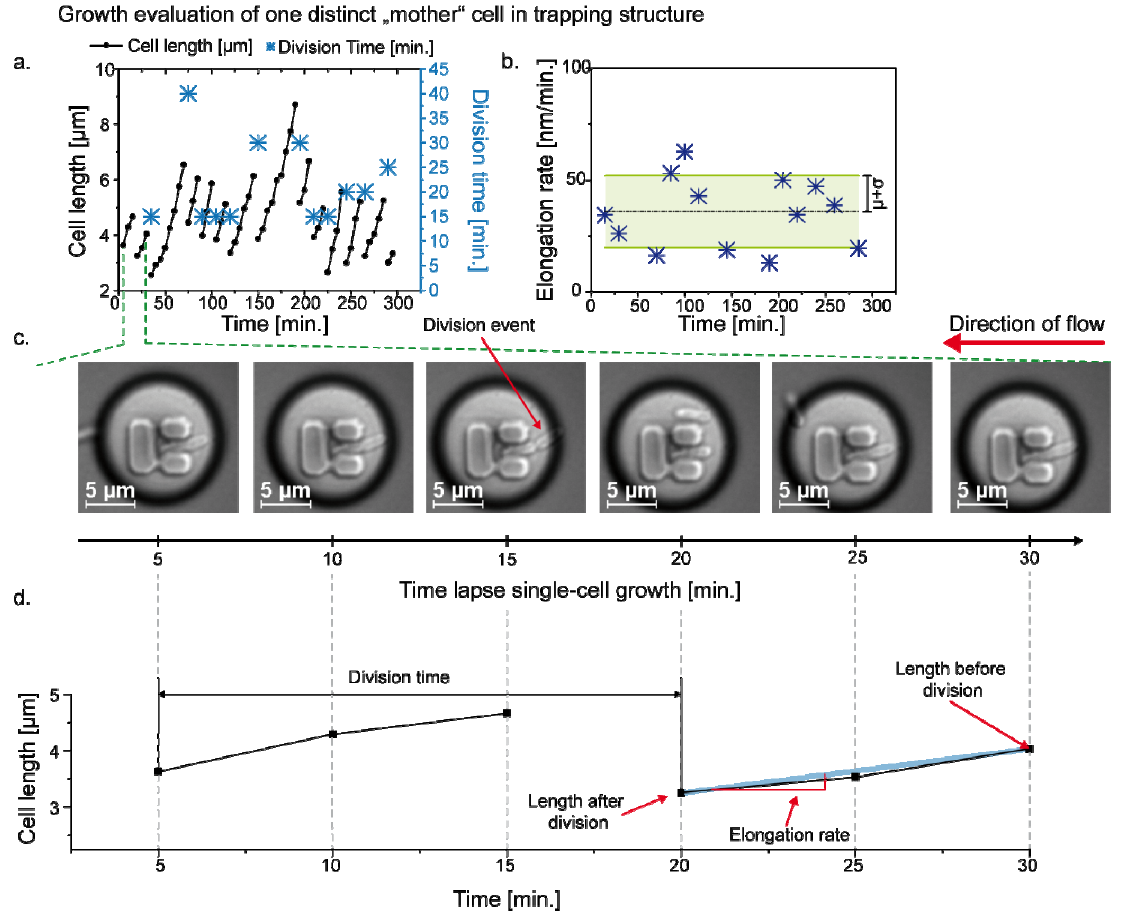
Figure 5. ( a , b ) Single-cell traces (cell length, division time and elongation rate) of one distinct E. coli mother cell. ( c ) Time-lapse image series showing the successful removal of a “daughter” cell from the trap during cultivation. ( d ) Cell length over the 30 min of cultivation describing the determination of the division time as well as the elongation